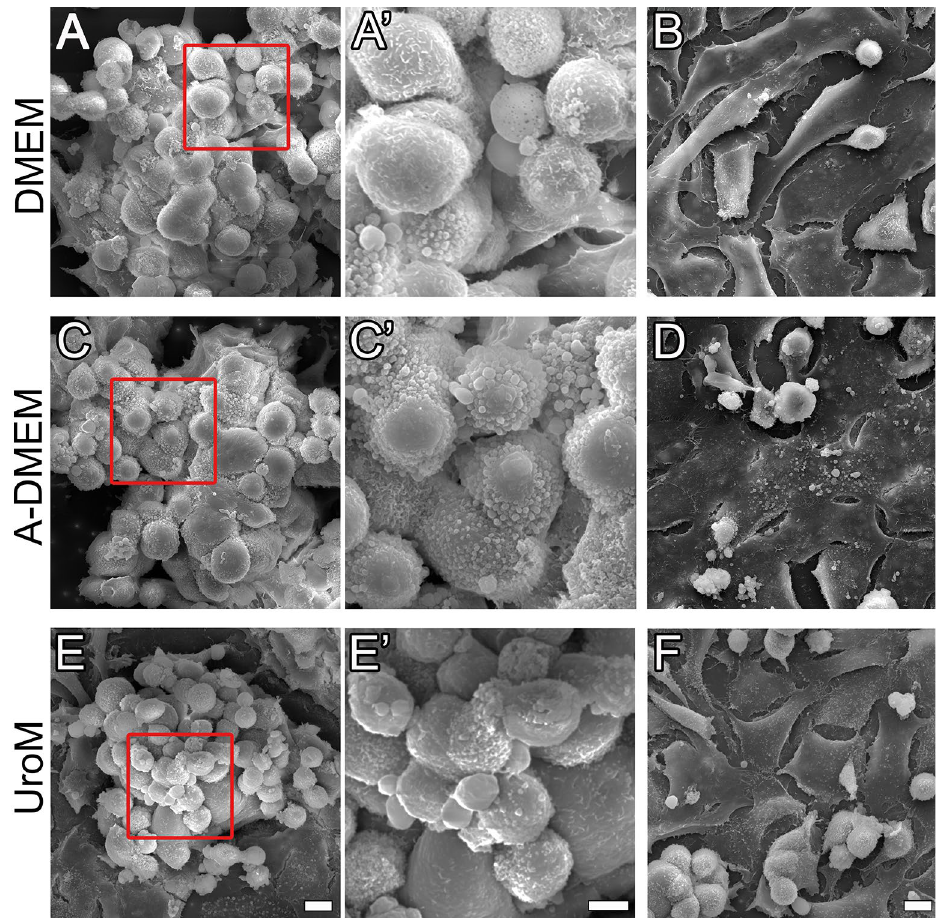
Figure 4. Apical surface structure of FLO-1 spheres surrounded by polygonal cells at the A–L interface. FLO-1 cells were cultured on porous membrane supports and maintained in DMEM, A-DMEM and UroM media for 4 wks and analyzed with high magnification SEM. In all media types, spheres consist of round to oval cells, which often have a rough surface ( A , A ’, C , C ’, E , E ’). Spheres are surrounded by polygonal cells, which show a smoother surface ( B , D , F ). The red boxed areas in images ( A , C , and E ) are shown in the magnified view in images ( A ’, C ’, and E ’), respectively. Scale bar, 10 µm ( A , B , C , D , E , F ), 5 µm ( A ’, C ’, E